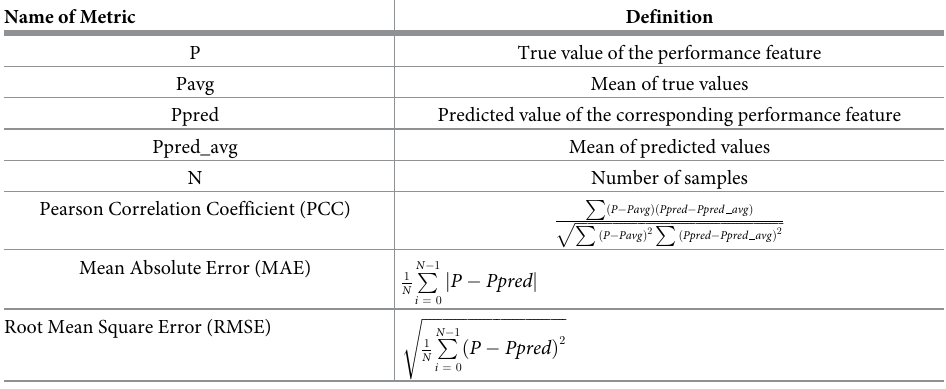
Table 1. Derivation of indices used to evaluate model classification and prediction.